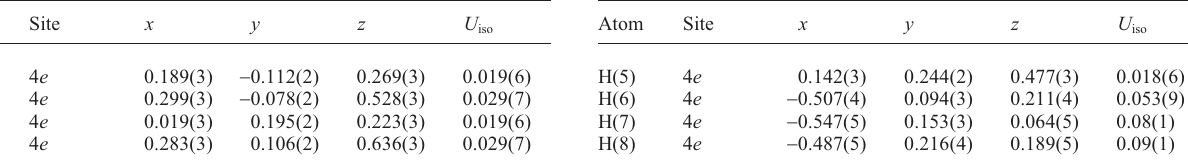
Table 2. Atomic coordinates and isotropic displacement parameters (in Å 2 ).